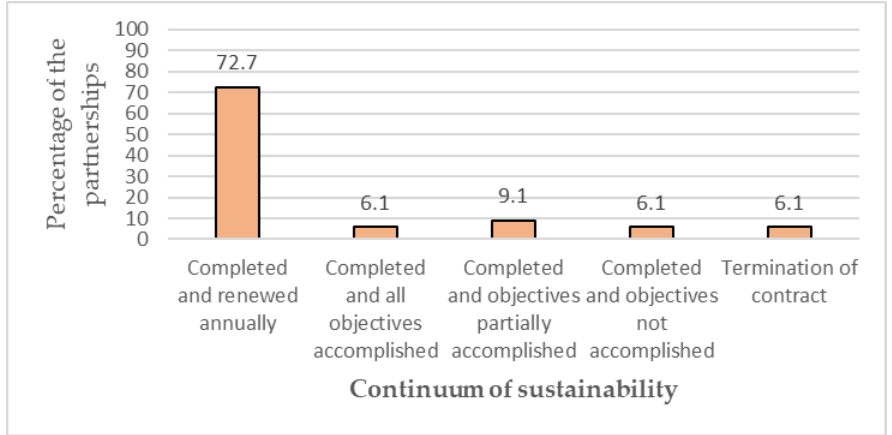
Figure 7. Sustainability continuum of the